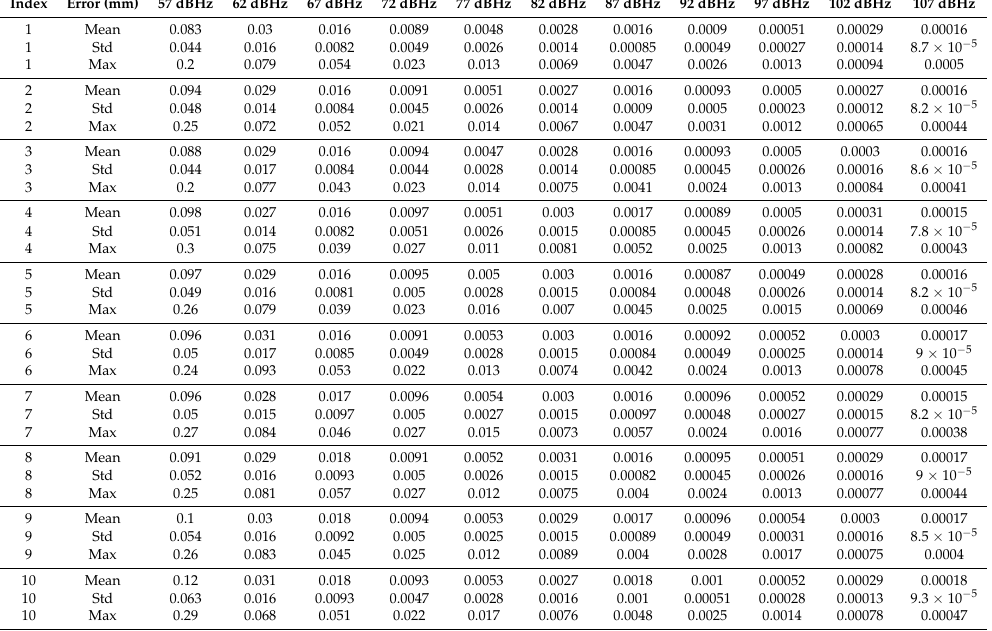
Table A5. Mean values, standard deviation, and maximum error values in the calculation of the impact point using FDMA-BPF with a 10-bit size.